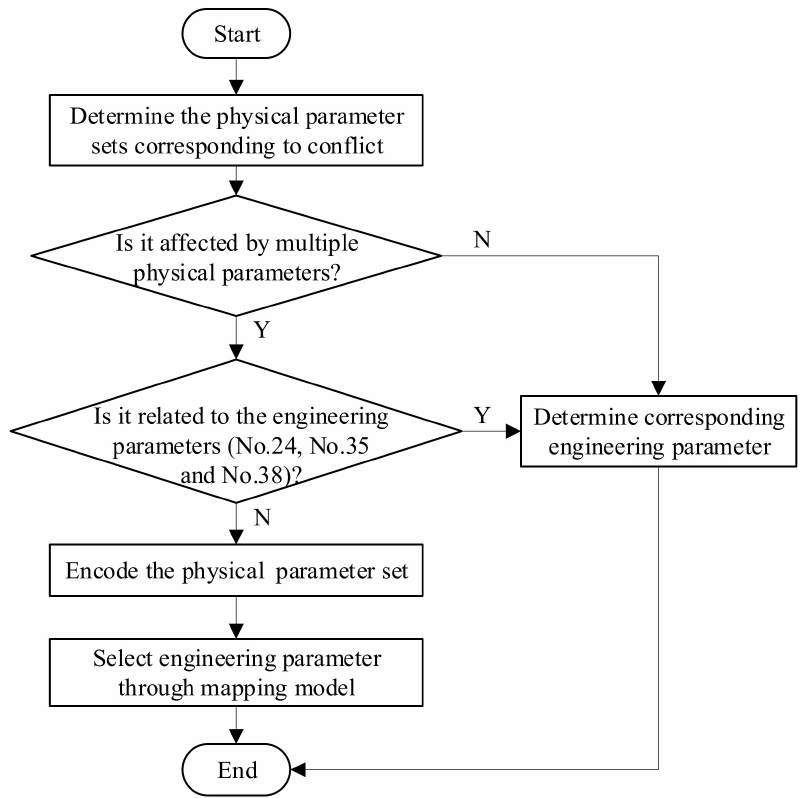
Figure 12. Engineering parameter selection process through mapping